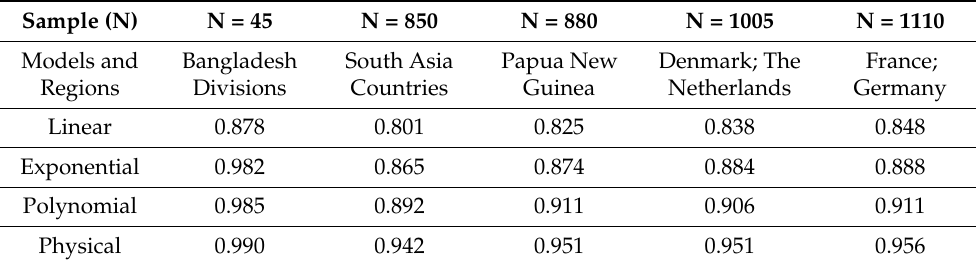
Table 2. Data sensitivity in modelling power estimations based on determination of coefficients.